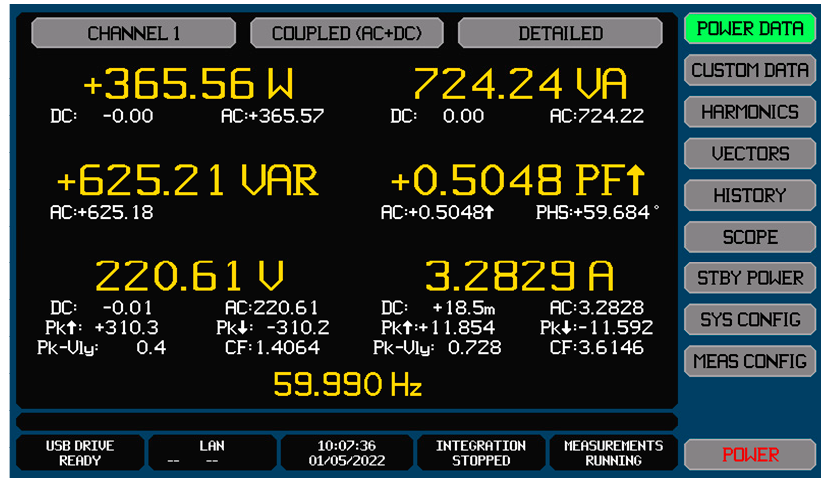
Figure 18. Apparent power, real power, and power factor value measured on the commercially available drive.